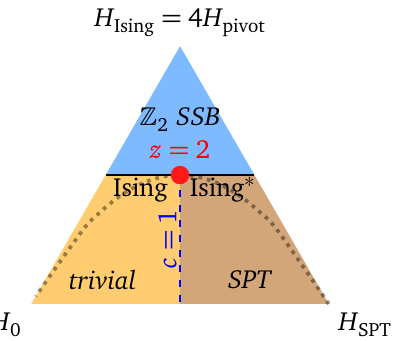
Figure 2: Phase diagram of the 1D cluster SPT transition perturbed by the Ising pivot: Hamiltonian (14) [ 61–63 ] plotted in barycentric coordinates. The central vertical axis has an explicit U ( 1 ) symmetry generated by H , which rotates the pivot trivial and SPT phases into one another. This stabilizes a compact boson transi- tion (‘ c = 1’) which eventually gaps out upon tuning the filling, making way for a symmetry-breaking phase which satisfies the mutual anomaly between the U ( 1 ) sym- × (cid:90) T metry and the (cid:90) symmetry protecting the SPT phase. In the center of the phase 2 2 diagram, we observe a multicritical point with dynamical critical exponent z = 2; this can be perturbed into two topologically distinct symmetry-enriched versions of the Ising criticality [ 46 ] . The dotted line is an exactly-solvable frustration-free line which tunes through the multicritical point [ 61–63 ] . It is instructive to compare this 1D phase diagram to a 2D analogue in Fig.